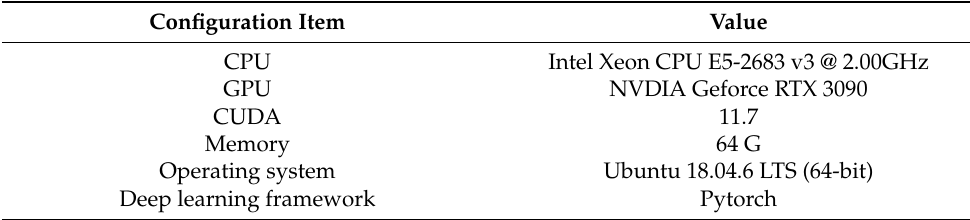
Table 2. Hardware and software